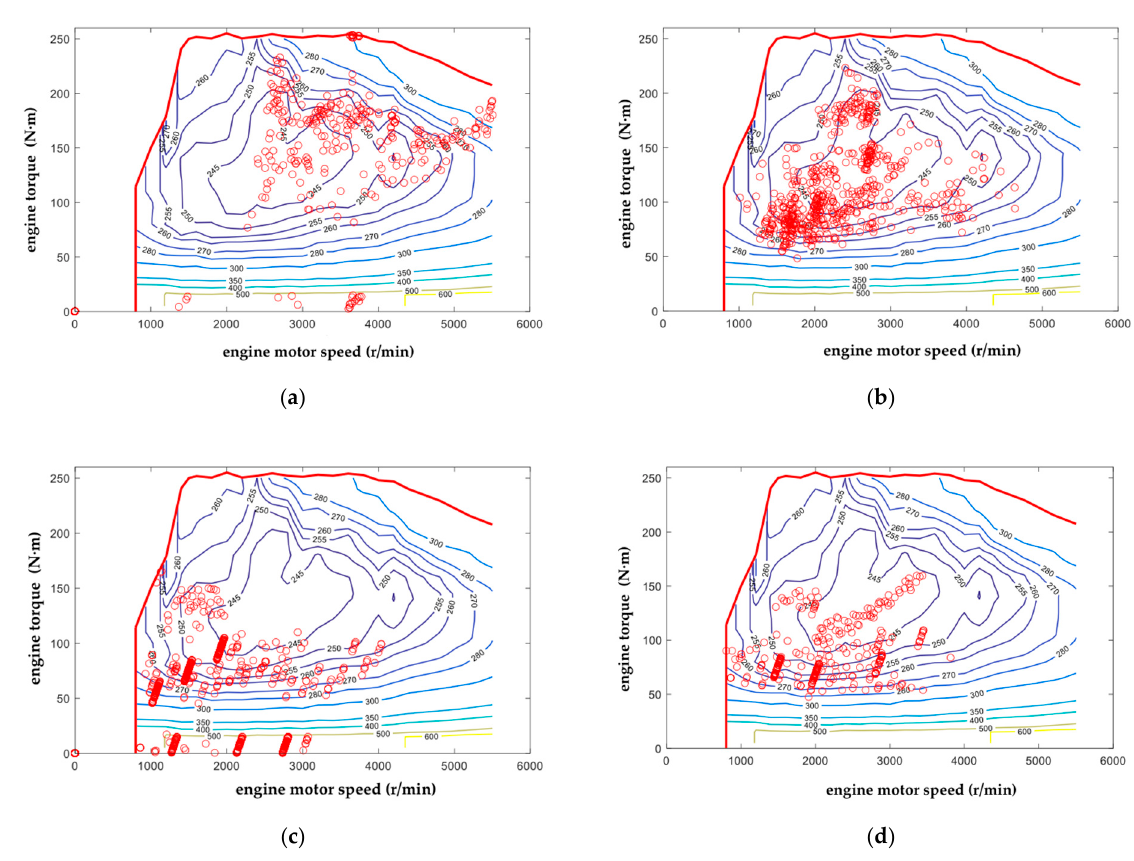
Figure 12. The engine operating points before and after using the optimized ECMS algorithm under the WLTC and the NEDC cycles: ( a ) The engine operating points before using the optimized ECMS algorithm under the WLTC cycle; ( b ) The engine operating points after using the optimized ECMS algorithm under the WLTC cycle; ( c ) The engine operating points before using the optimized ECMS algorithm under the NEDC cycle; ( d ) The engine operating points after using the optimized ECMS algorithm under the NEDC cycle.